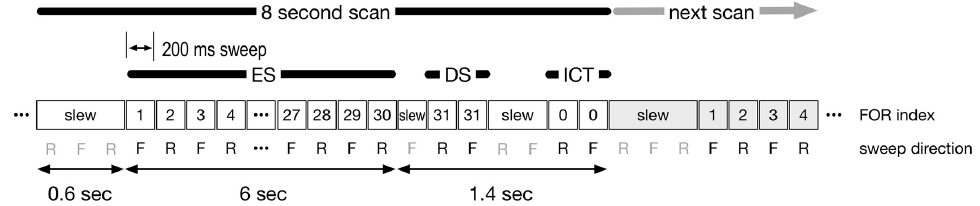
Figure 12. CrIS 8-s measurement scan sequence. The interferometer sweep directions are denoted as ‘F’ for forward and ‘R’ for reverse. The 200-millisecond interferometer sweep time includes turnaround at end of scan.